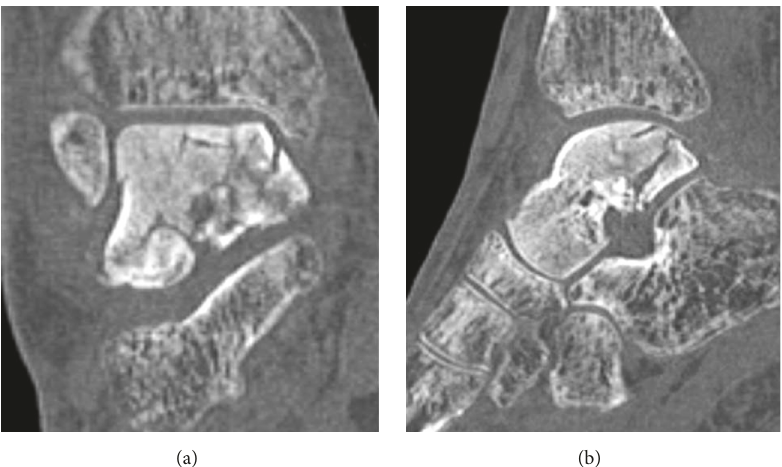
Figure 7: Preoperative CT showing sclerotic change and collapse of the talar body in coronal (a) and sagittal (b) views.